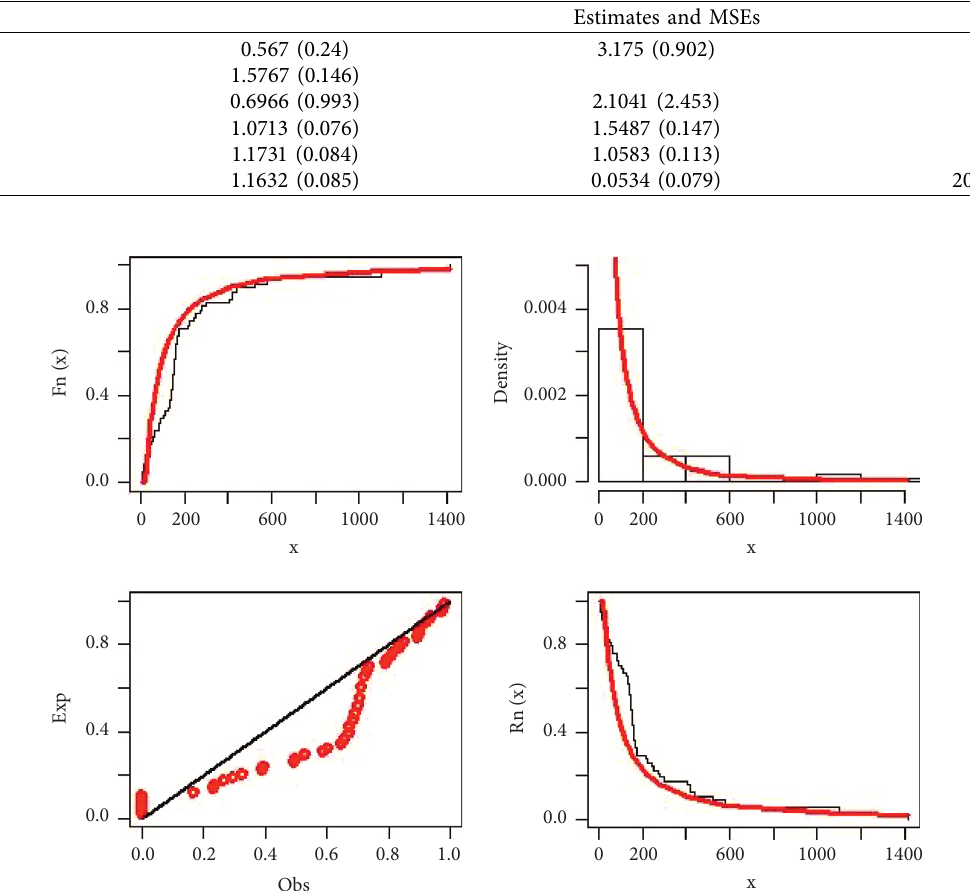
Table 9: Parameter estimates and the standard error in parentheses for dataset II.